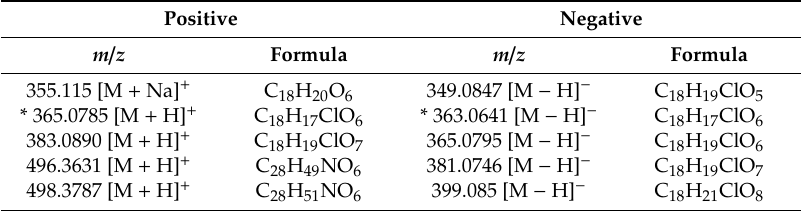
Table 1. The five most abundant compounds produced by virulent and avirulent strains of Ilyonectria grown on potato dextrose agar in positive and negative ionization modes. (*) indicates radicicol, the most abundant compound in both ionization modes.